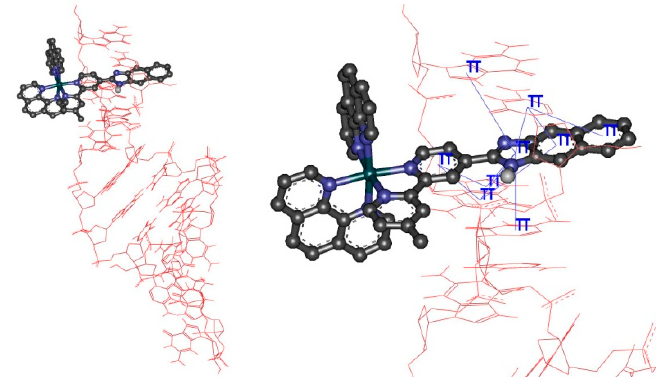
Figure 6. The ds-DNA (PDB: 4E7Y) binding conformation of complex 2 by docking.